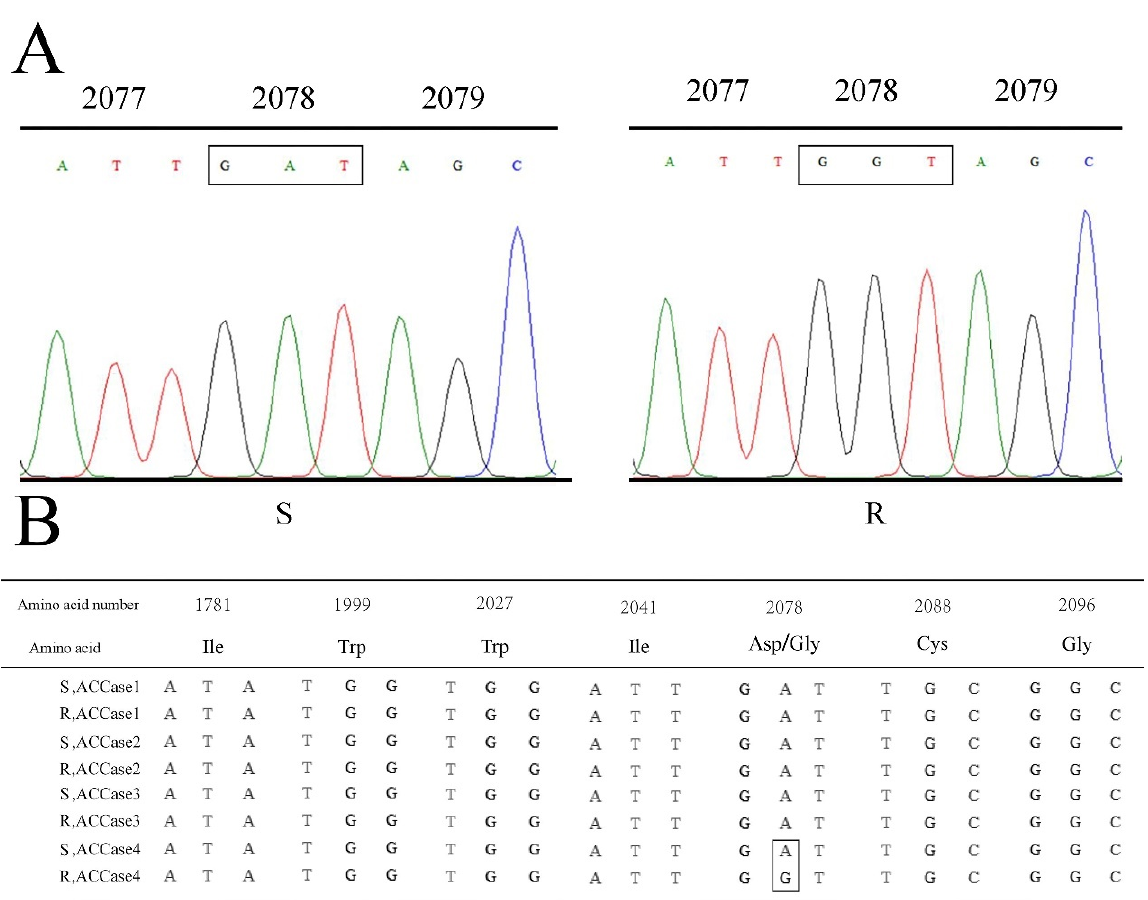
Figure 1. Comparison of sequencing results between R and S population: ( A ) GAT for Asp (left) in the S population and GGT for Gly (right) in the R population at codon position 2078. ( B ) Sequence alignment of four ACCase copy genes of R and S populations at 7 amino acid positions related to resistance and the wireframe reveals the mutation from Asp to Gly. R, the resistant population; S, the sensitive population.